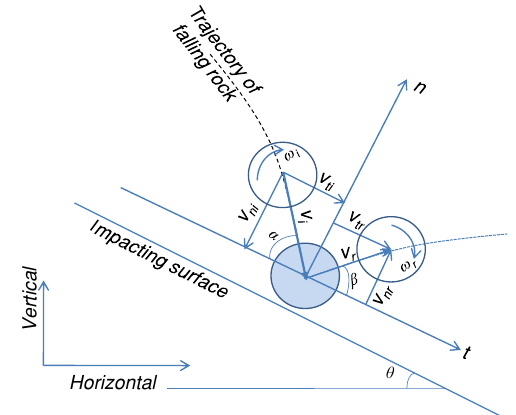
Figure 1. Related quantities adopted in the definitions for the coef- ficient of